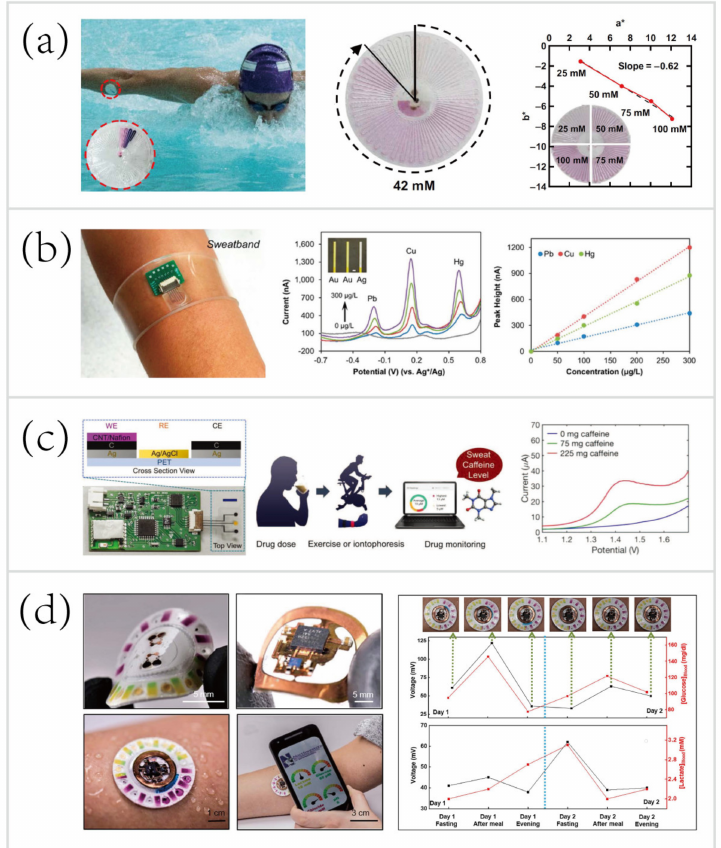
Figure 10. Wearable sweat biosensing platforms for healthcare and sports monitoring. ( a ) A waterproof skin-interfacedmicrofluidicbiosensorforsweatchlorideanalysisinaquaticsettings[33]. Copyright2019, AmericanAssociationforAdvancementofScience. ( b